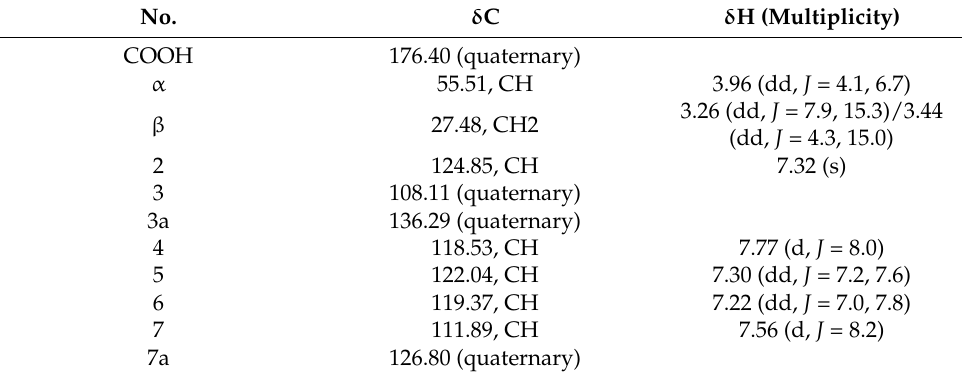
Figure 5. Nuclear magnetic resonance (NMR) spectra of D-tryptophan (Trp). (( A ): 1 H NMR, ( B ): 13 C NMR, ( C ): 1 H– 1 H COSY, ( D ): HSQC, ( E ): HMBC). Table 3. NMR data assignments of D-tryptophan